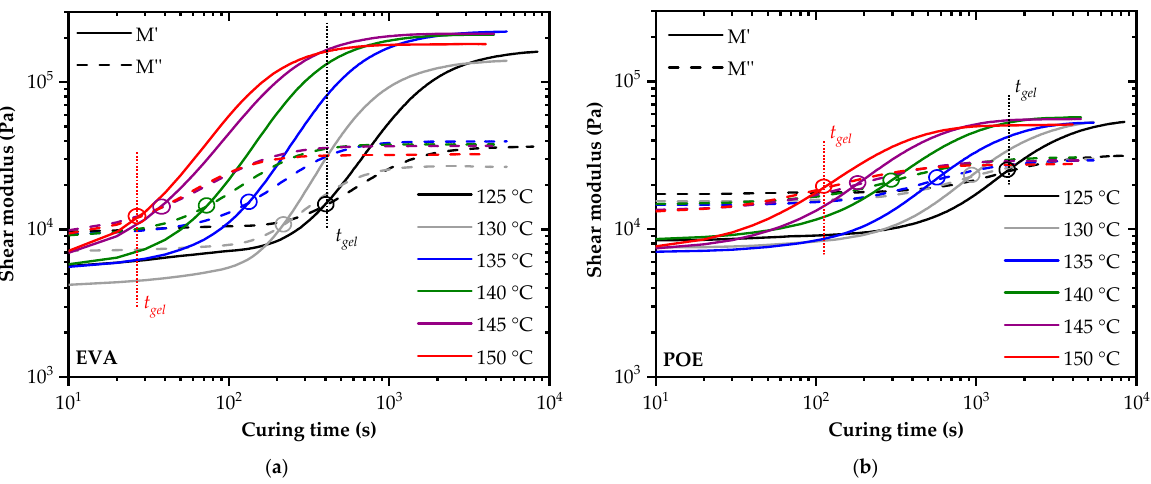
Figure 3. Storage and loss modulus curves of EVA ( a ) and POE ( b ) at different isothermal curing temperatures ( t gel …gelation time).